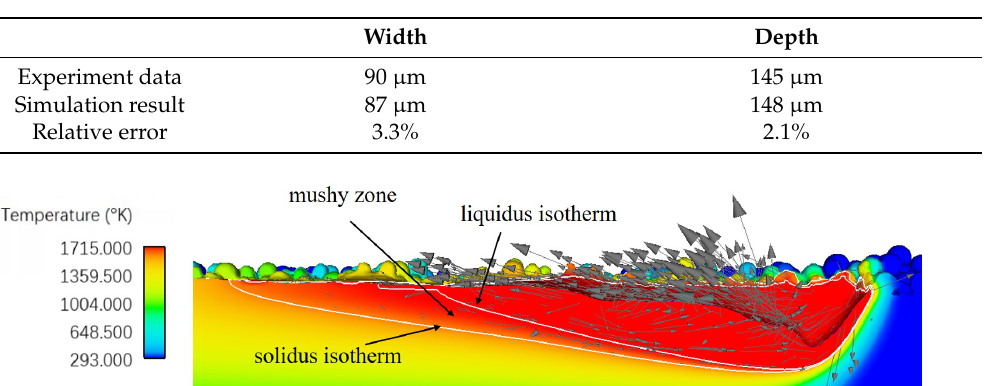
Table 6. Comparison of melt pool width and depth between experiment data and simulation results for Case P180V63.